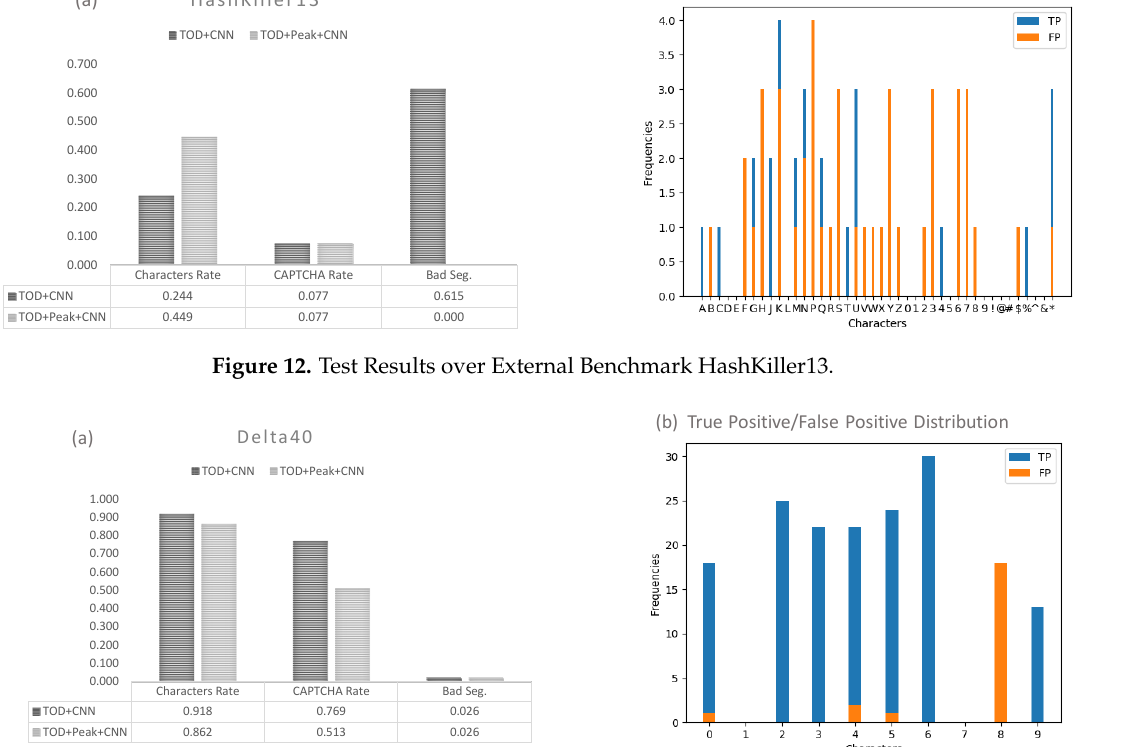
Figure 13. Test Results over External Benchmark